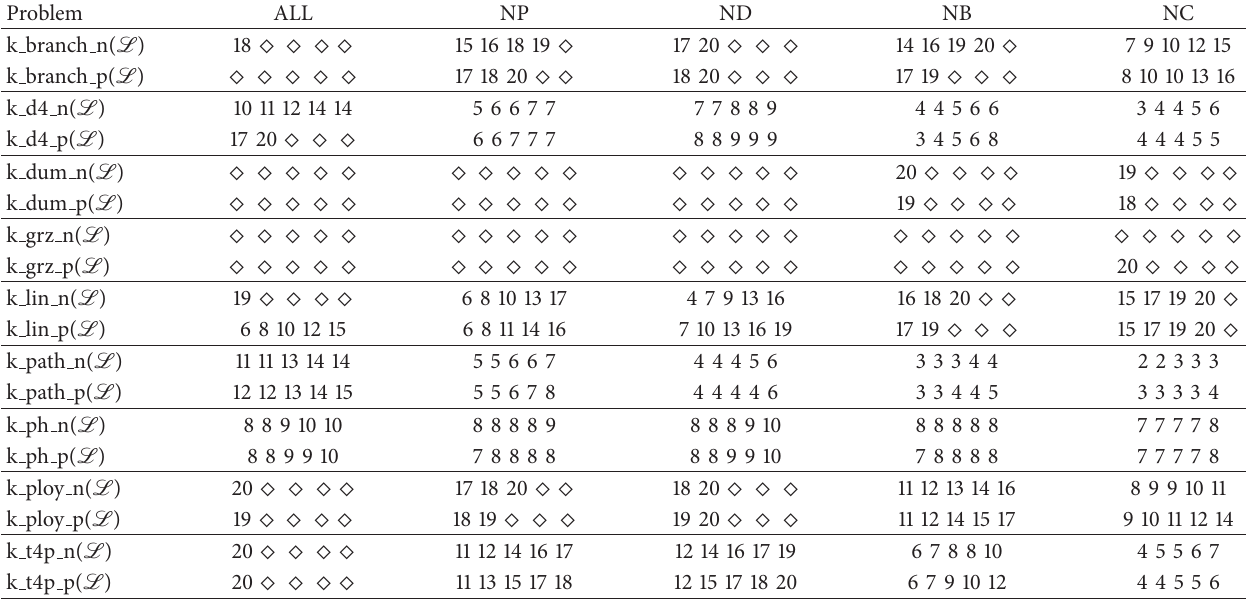
Table 4: Results for K( L ) tests.